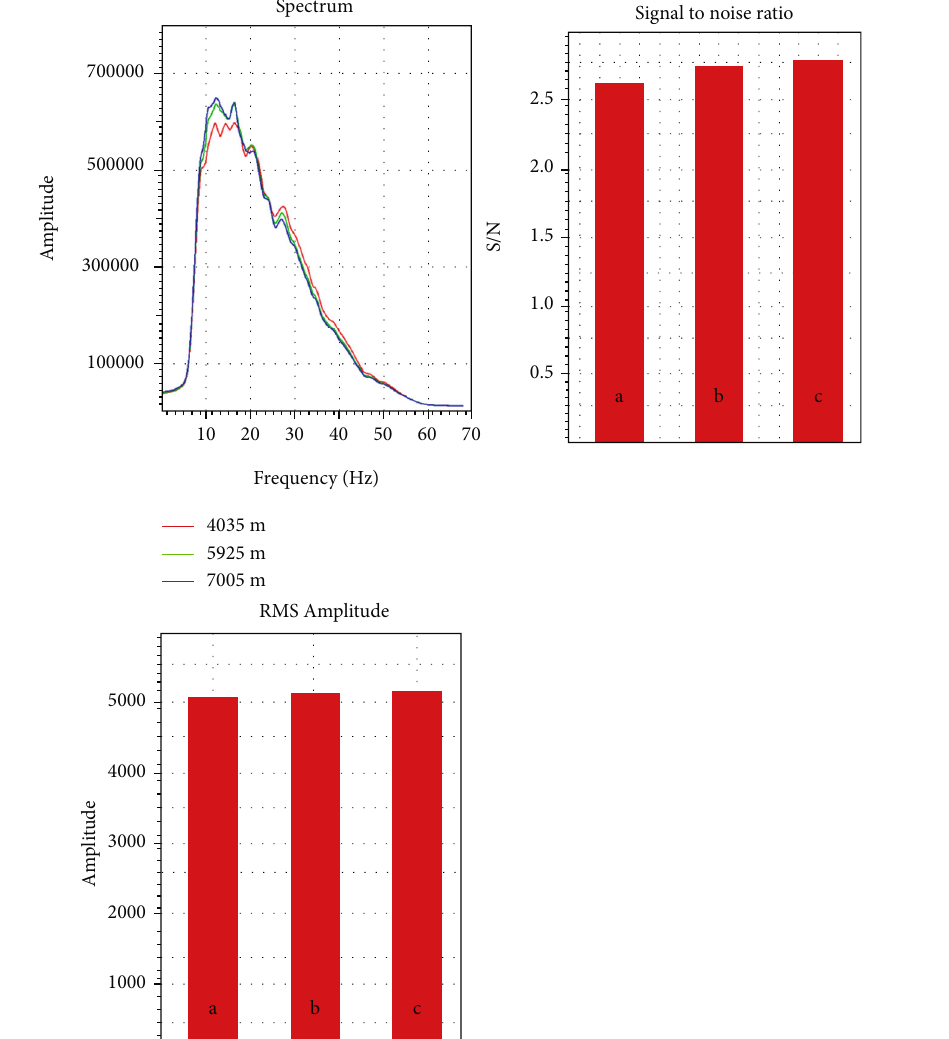
Figure 12: Quantitative analysis of the seismic sections with di ff erent maximum o ff sets (a: o ff set 4035 m; b: o ff set 5925 m; c: o ff set